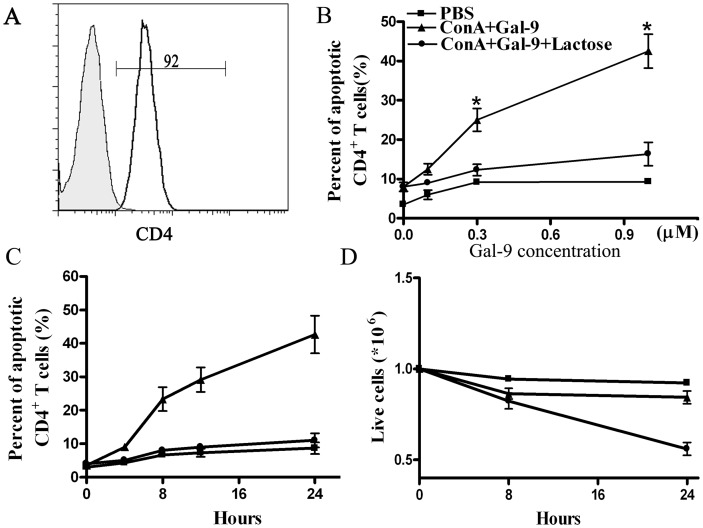
Galectin-9 induced apoptosis of Con A–activated CD4+ T cells at day-5.(A) The purity of isolated CD4+ T cells. (B) Spleen CD4+ T cells, isolated from untreated mice, were cultured with 10 µg/mL Con A for 5 days and then cultured for 24 hours at 37°C with or without 30 mM lactose followed by indicated doses of galectin-9, then apoptotic cells were assessed by FACS. (C) Time-course of galectin-9 (1 µM) induced apoptosis of day-5 Con A–activated T cells. (D) Absolute number of live cells after galectin-9 treatment, determined by Trypan blue dye exclusion. The results were presented as the mean ± SD of three separate experiments. *, P<0.05 vs PBS treatment.